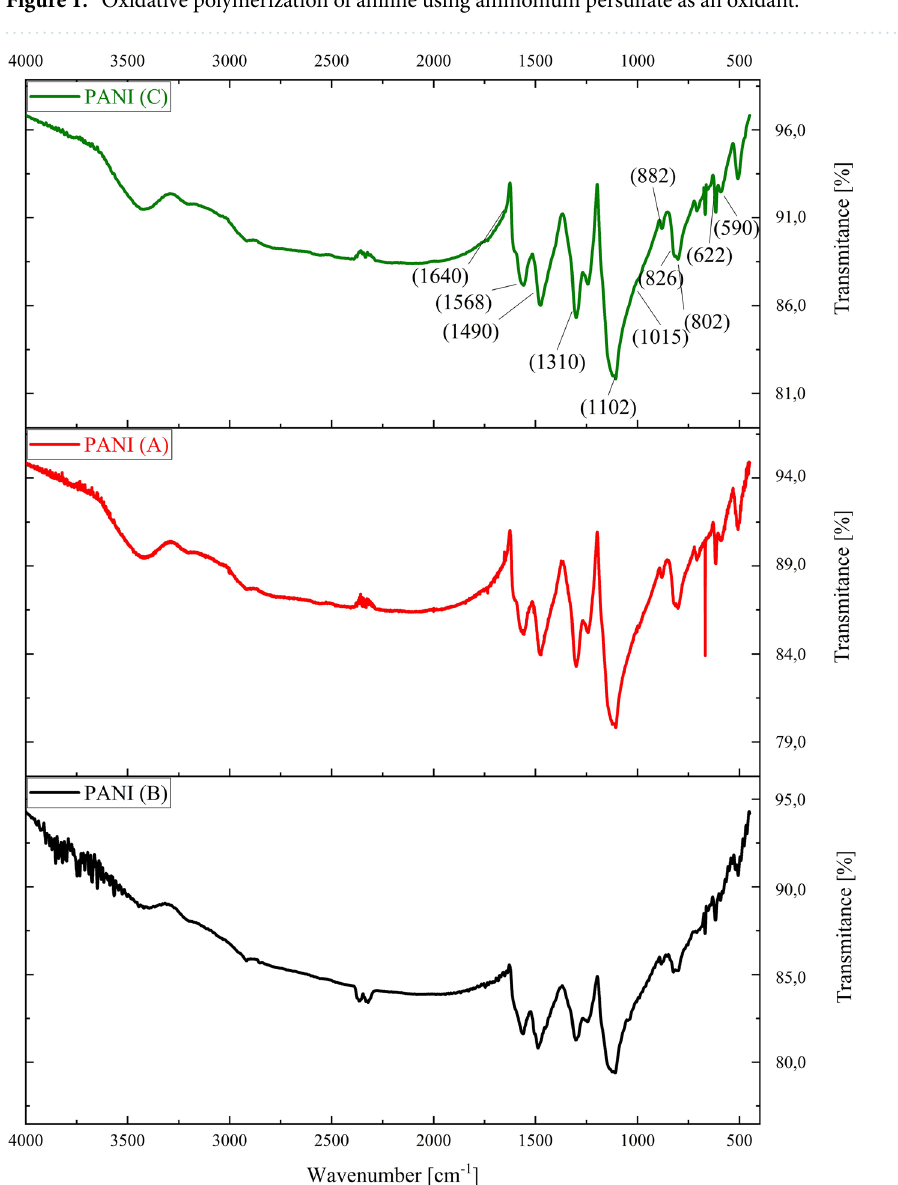
Figure 2. FTIR spectra of synthesized polyanilines (A, B,